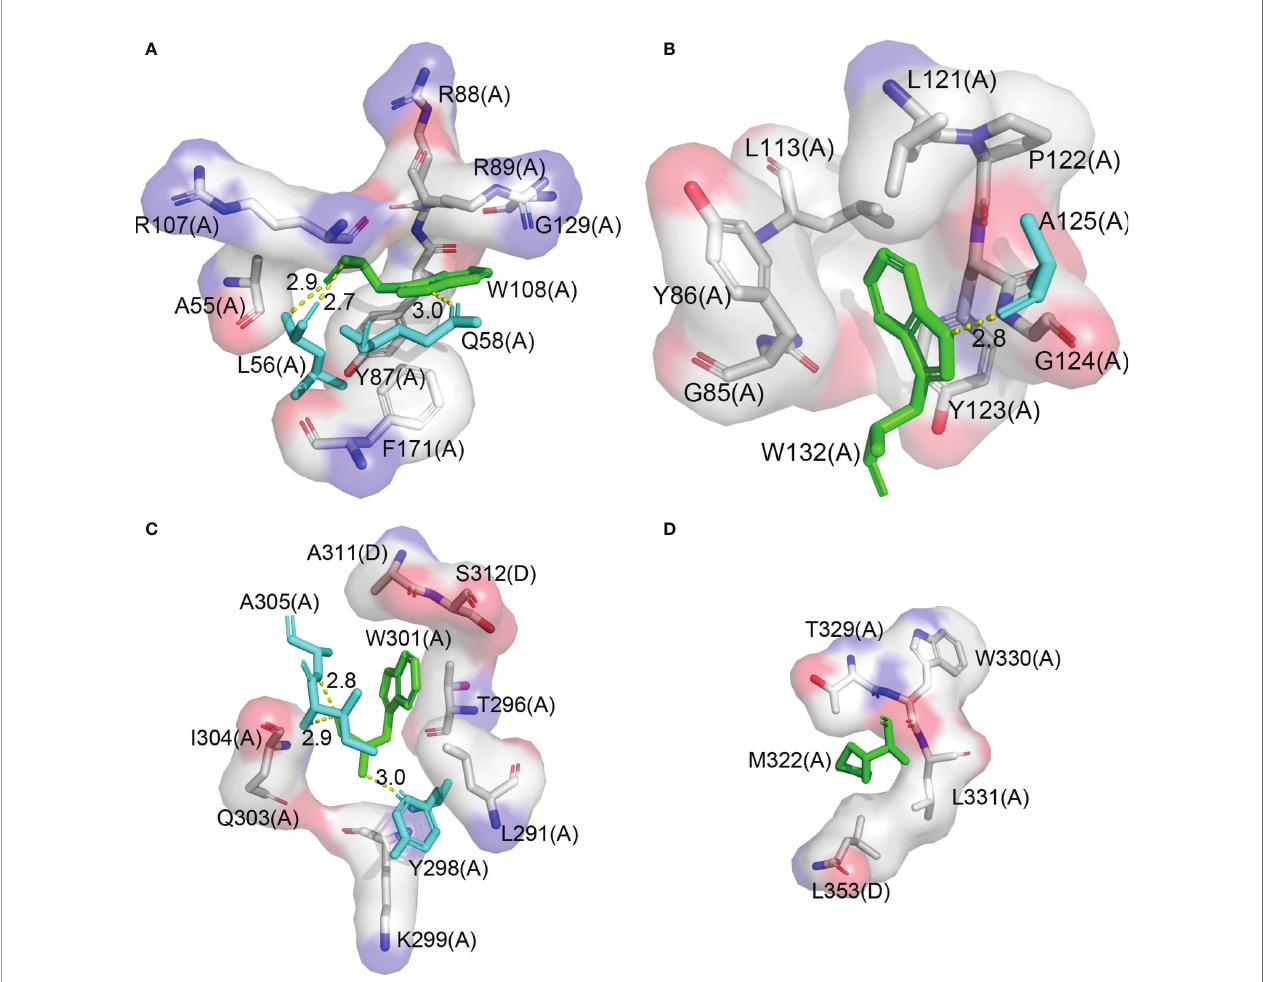
FIGURE 3 | W108, W132, W301, and M322 are in the structure core of the N protein. (A) The interaction diagram of W108 in the N protein structure. (B) The interaction diagram of W132 in the N protein structure. (C) The interaction diagram of W301 in the N protein structure. (D) The interaction diagram of M322 in the N protein